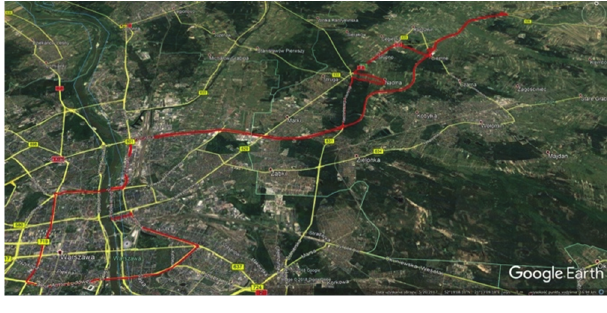
Fig. 4. RDE test route